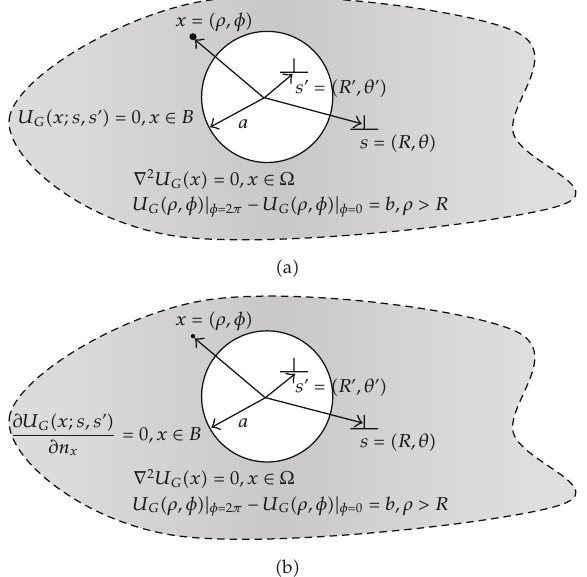
Figure 5: 2D exterior problem (cid:5) a (cid:6) Dirichlet boundary condition and (cid:5) b (cid:6) Neumann boundary